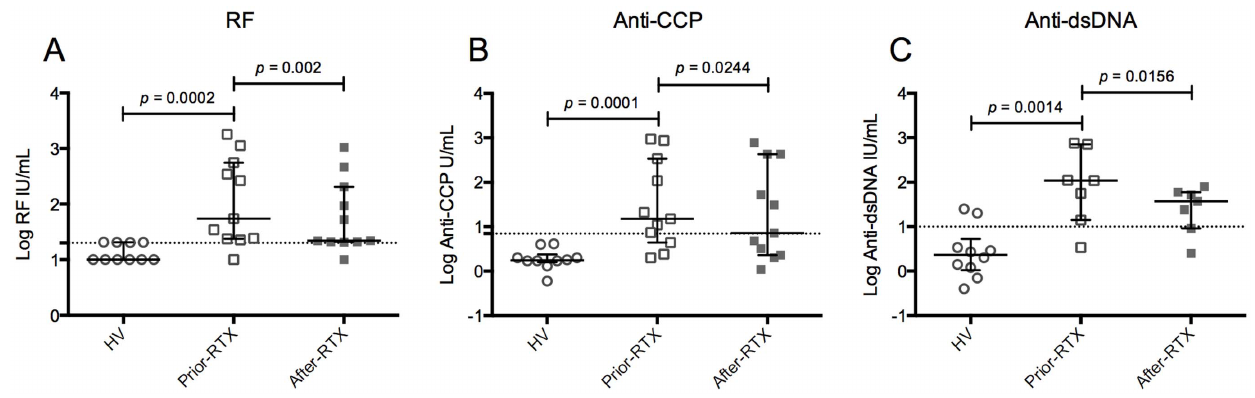
Figure 5. Comparison of RF, anti-CCP and anti-dsDNA autoantibodies levels in plasma among the study groups. Levels of rheumatoid factor (RF) determined by kinetic nephelometry ( A ), anti-cyclic citrullinated peptide (anti-CCP) ( B ) and anti-doubled stranded DNA (anti-dsDNA) ( C ) determined by a fluorescence enzyme immunoassay (EliA test) in patients diagnosed with RA ( A and B ) (n=11) or with SLE ( C ) (n=7) (some patients had both diagnoses). Solid lines and error bars denote the median and interquartile range, respectively. The dotted lines correspond to the clinical limits below which a sample is considered negative according to the technique used for its detection (RF: , 20 IU/mL, anti-CCP: , 7 U/mL and anti- dsDNA: , 10 IU/mL). Differences between HV and patients prior-RTX were evaluated with Mann–Whitney tests and between patients prior-RTX and patients after-RTX with Wilcoxon tests. All p values reported are 2-tailed.